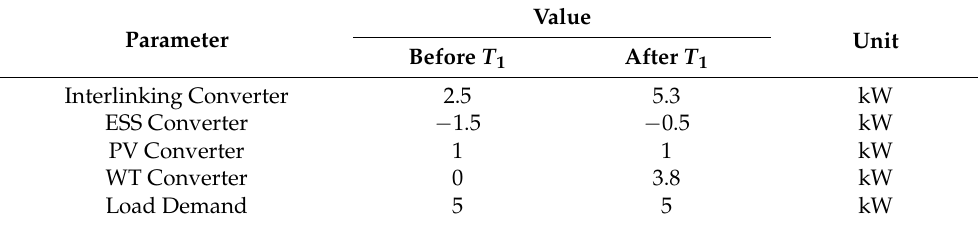
Table 6. Power flow of each power converter in operation mode 3.